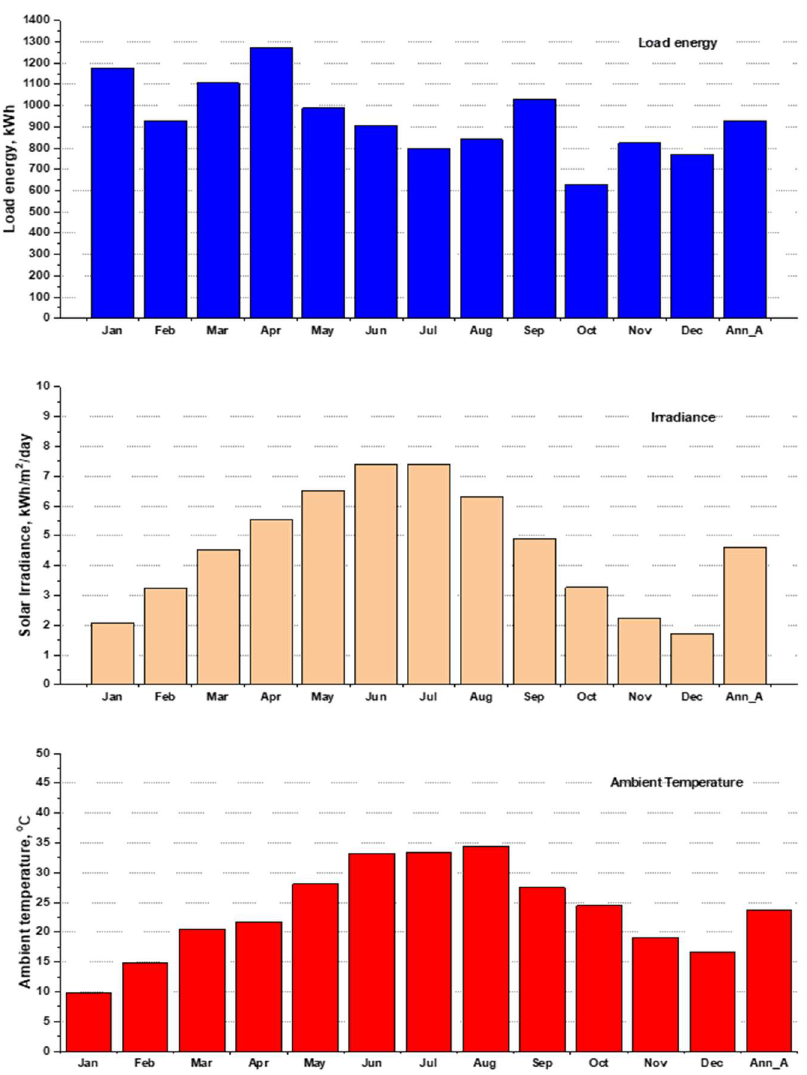
Figure 5. The monthly and yearly averages of the energy consumption, solar irradiance, and ambient temperature.